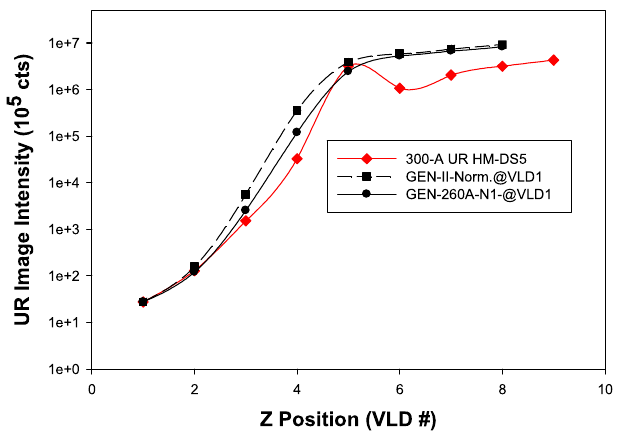
FIG. 14. (Color) Another example of the imaging spectrometer data showing the COTR x - (cid:2) dependence near the 530-nm fundamental wavelength after undulator 6 from December 20, 2001